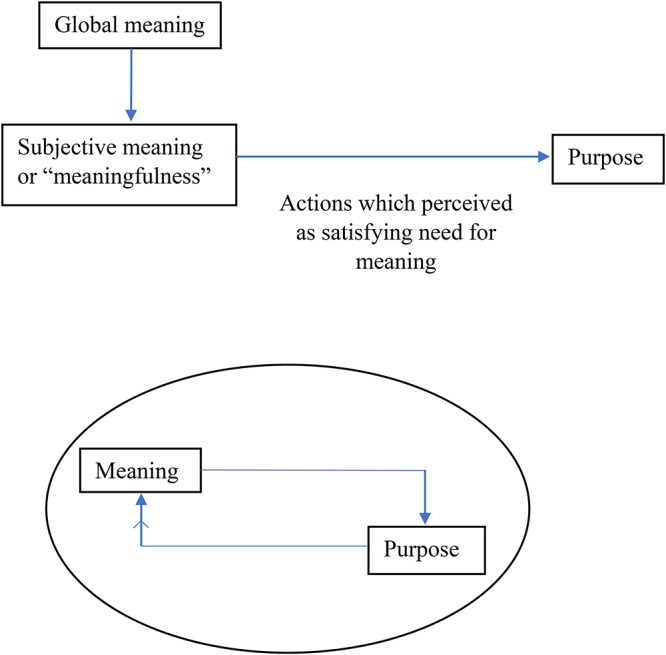
The proposed relationship between purpose and Meaning in life according to McKnight and Kashdan (2009) and Park (2010). A strong sense of meaning can lead to development of a sense of purpose. This subsequently sustains a sense of meaning through a bidirectional relationship.